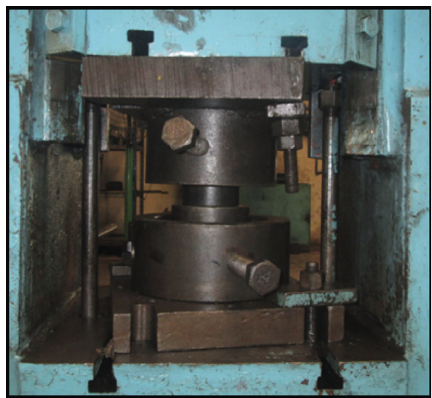
Figure 2: Cold compaction process.